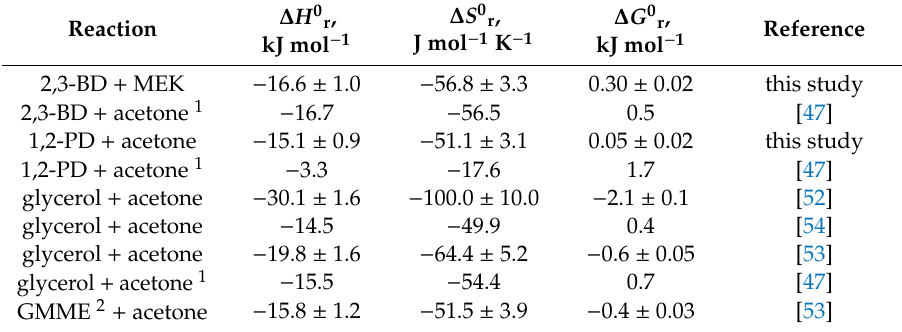
Table 2. The values of thermodynamic parameters for the diol ketalization